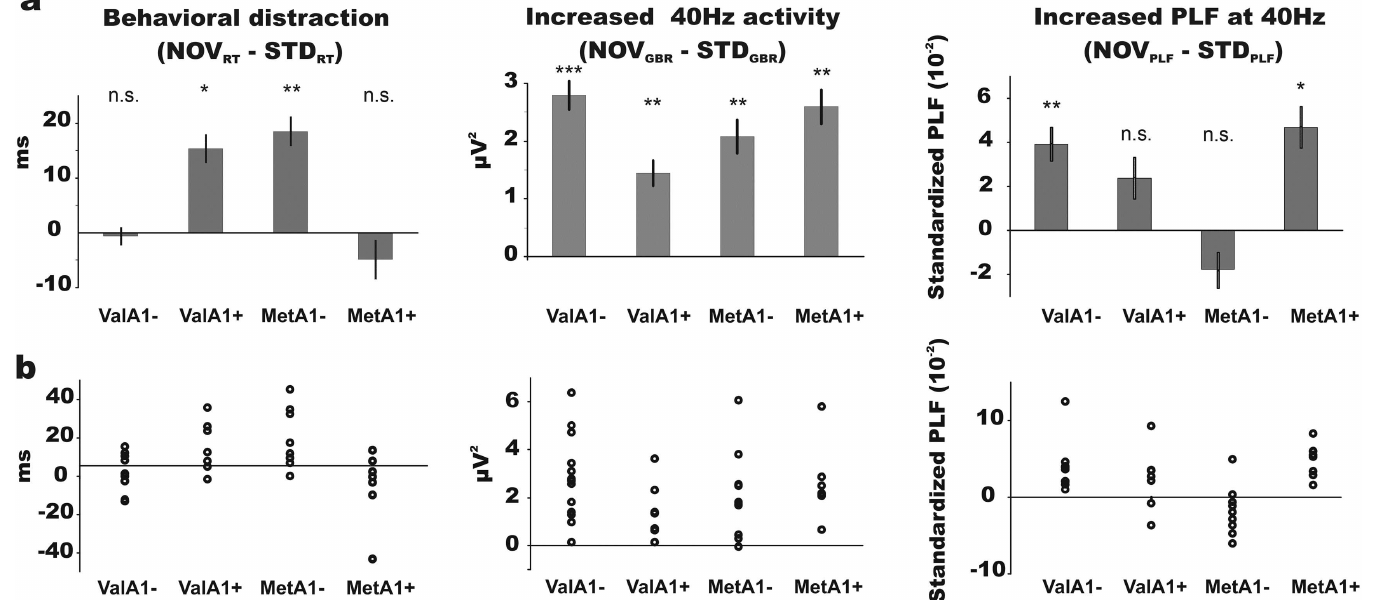
Fig 3. RT, amplitude and PLF of 40 Hz oscillatory activity for novel relative to standard trials. ( a ) Left panelshows the mean RT for novel comparedto standardtrials; notice that only the ValA1+ and MetA1- groups had larger RT for novel as comparedto standardtrials. Middle panelshows the increasein amplitudeof neuraloscillations at 40 Hz locked to novel sounds comparedto that locked to standard sounds at Cz. Notice that amplitudeswere larger after novel compared to standard sounds in all four groups. Right panel shows the increase of the PLF of neuraloscillations at 40 Hz locked to novels sounds relativeto that locked to standard sounds at Cz. Notice that PLF was larger after novel comparedto standardtrials in only the ValA1- and MetA1+ groups. ( b ) Scatter plots of individual values for RT (left panel), amplitudeof the evoked 40 Hz oscillatory activity (middlepanel), and PLF of the 40 Hz oscillatory activity (right panel). ( * , p < 0.05; ** , p < 0.01; *** , p < 0.001;n.s., p >